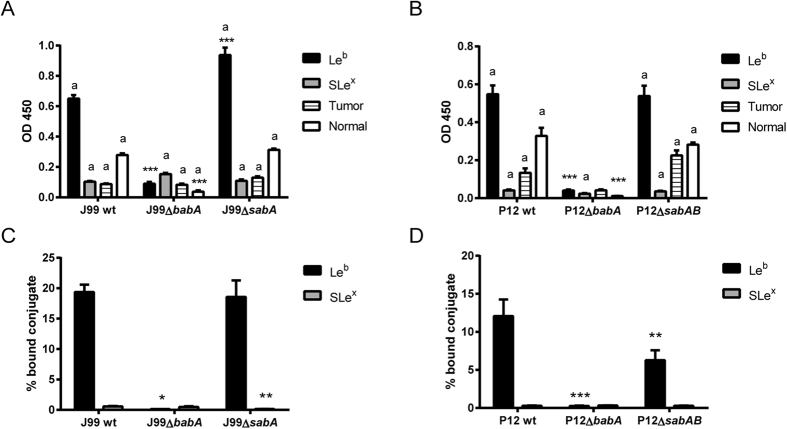
Binding of J99 and P12 wt and isogenic adhesin mutants to glycoconjugates and mucins.Binding of strain J99 (A) and P12 (B) to Leb- and SLex-glycoconjugates, the tumor derived and normal mucin coated onto microtiter plates (n = 4). The results in the graphs have been reproduced at least twice with the same outcome. Values are mean ± S.E.M. Stars indicate statistical relationship of mutant binding compared to the binding of the isogenic wt to the same ligand, One-way ANOVA with Bonferroni’s post hoc test, *p ≤ 0.05, **p ≤ 0.01, ***p ≤ 0.001, whereas the letter a indicates that the binding (depicted after subtraction of the background signal) is statistically different (p < 0.05) from the background signal. Binding of strain J99 (C) and P12 (D) to Leb- and SLex-glycoconjugates in solution using RadioImmuno assay (n = 9–10). Values are median ± interquartile range. Stars indicate statistical relationship of mutant binding compared to the binding of the isogenic wt to the same ligand, Kruskal-Walllis One-way ANOVA on ranks with Dunn’s multiple comparisons test, *p ≤ 0.05, **p ≤ 0.01, ***p ≤ 0.001.